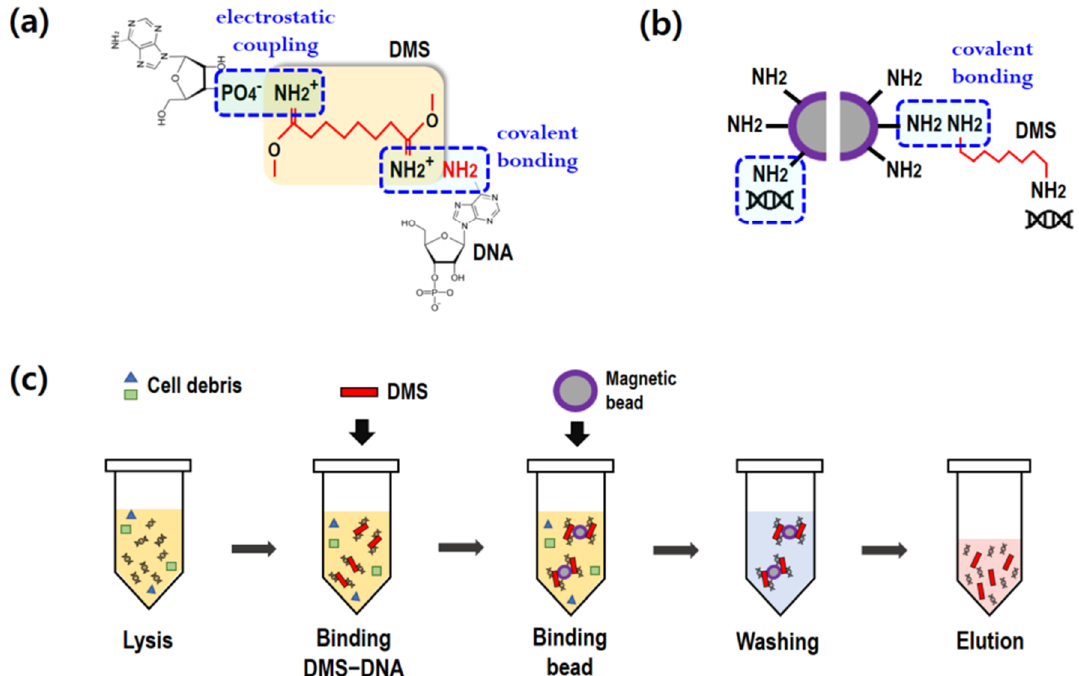
Figure 1. Schematic for cfDNA extraction using a homobifunctional imidoester crosslinker (DMS) and magnetic beads. ( a ) Binding schemes between DMS and DNA. ( b ) Binding between amine-coated magnetic beads and DMS–DNA complexes. ( c ) Standard protocol for cfDNA extraction using the present method.